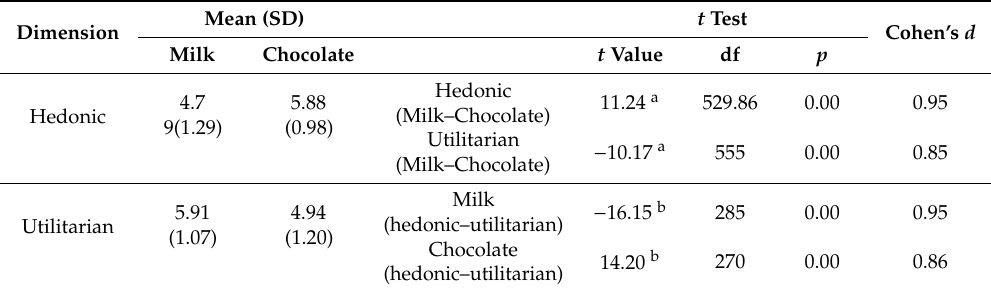
Table 3. Validation of the di ff erences between products and